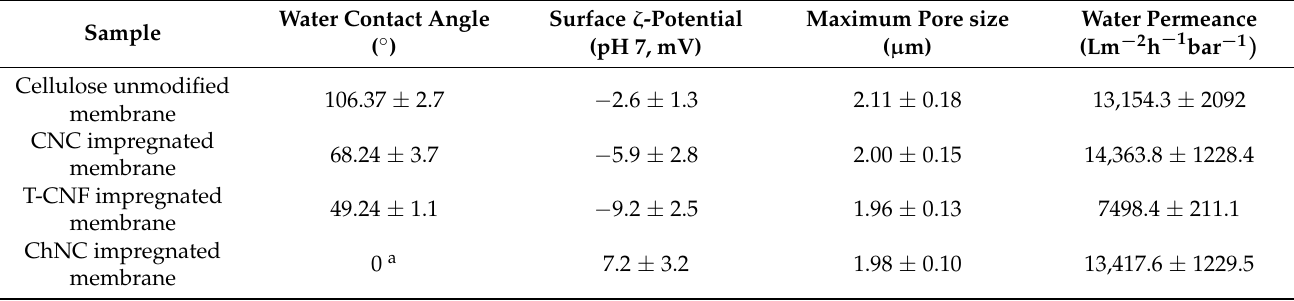
Table 1. Contact angle, surface ζ -potential, maximum pore size, and permeance of unmodified and impregnated fabrics.